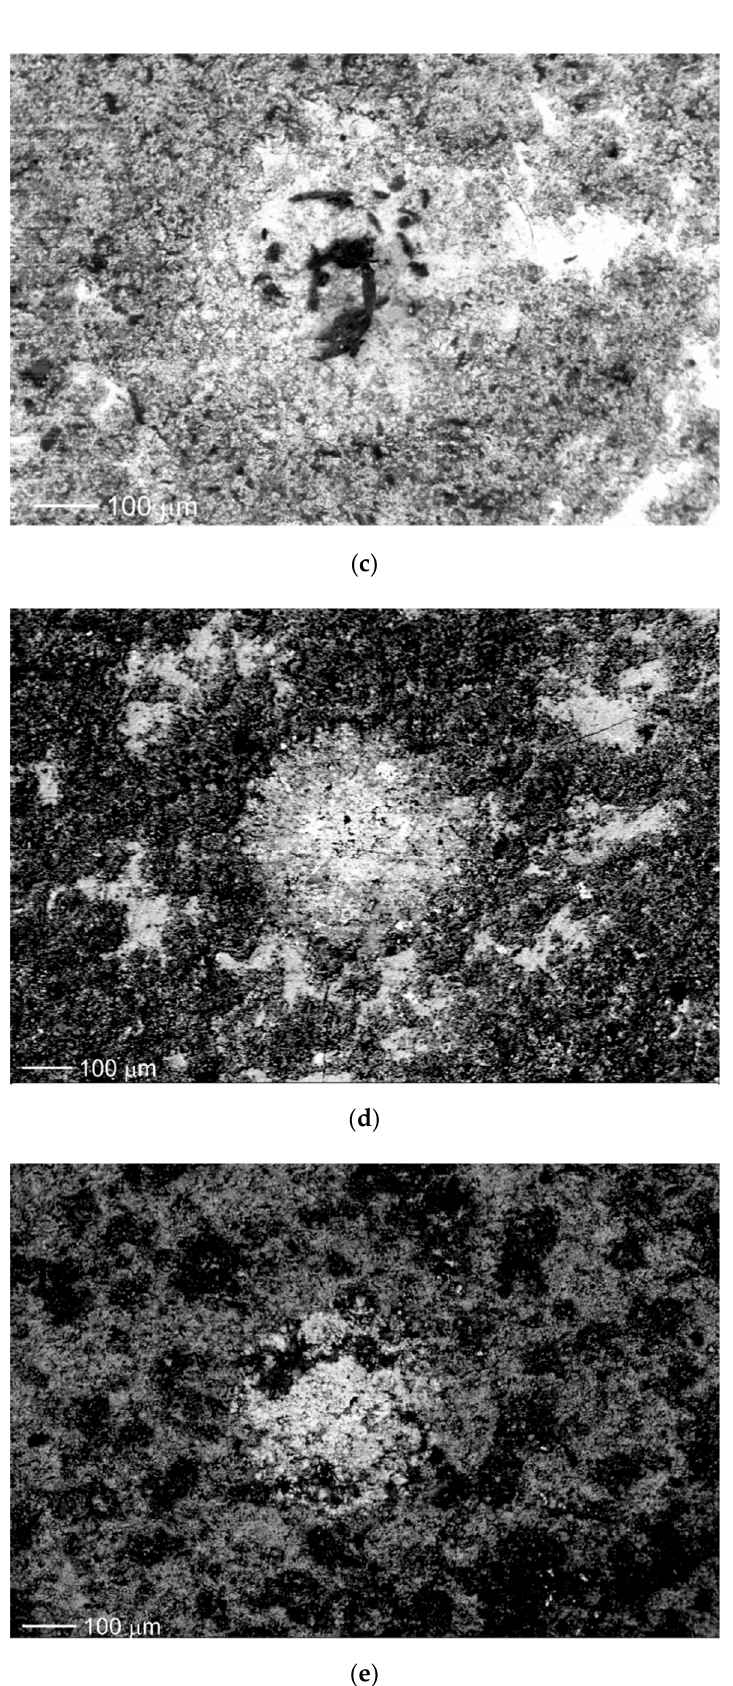
Figure 1. HRC imprints of ( a ) WC-Cr 3 C 2 -Ni; ( b ) WC-Ni; ( c ) WC-Co-Cr; ( d ) Cr 3 C 2 -NiCr and ( e ) WC-Co.